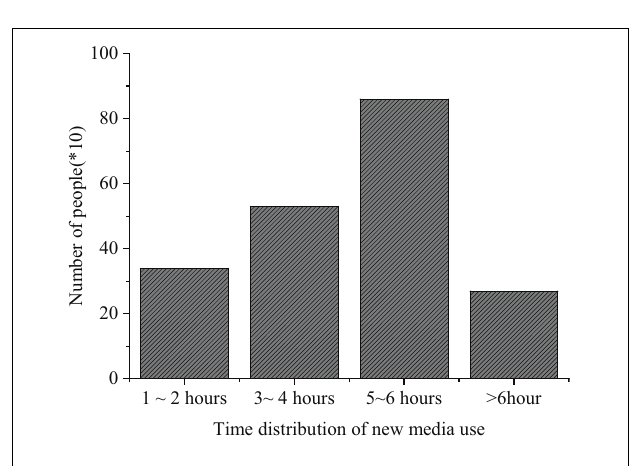
FIGURE 9 | Questionnaire Survey of the new media utilization time.